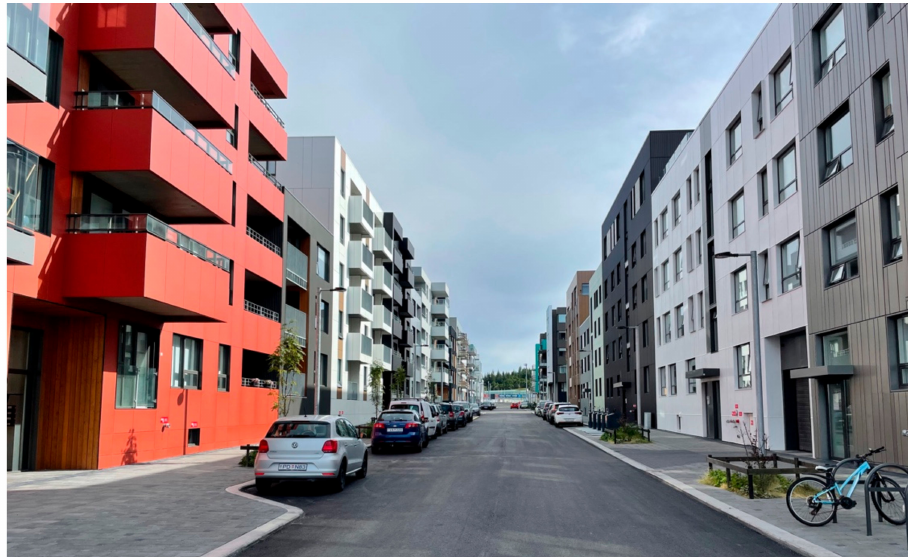
Figure 15. Photograph of case study 4: Hl í ðarf ó tur 13–17. Source: Authors.